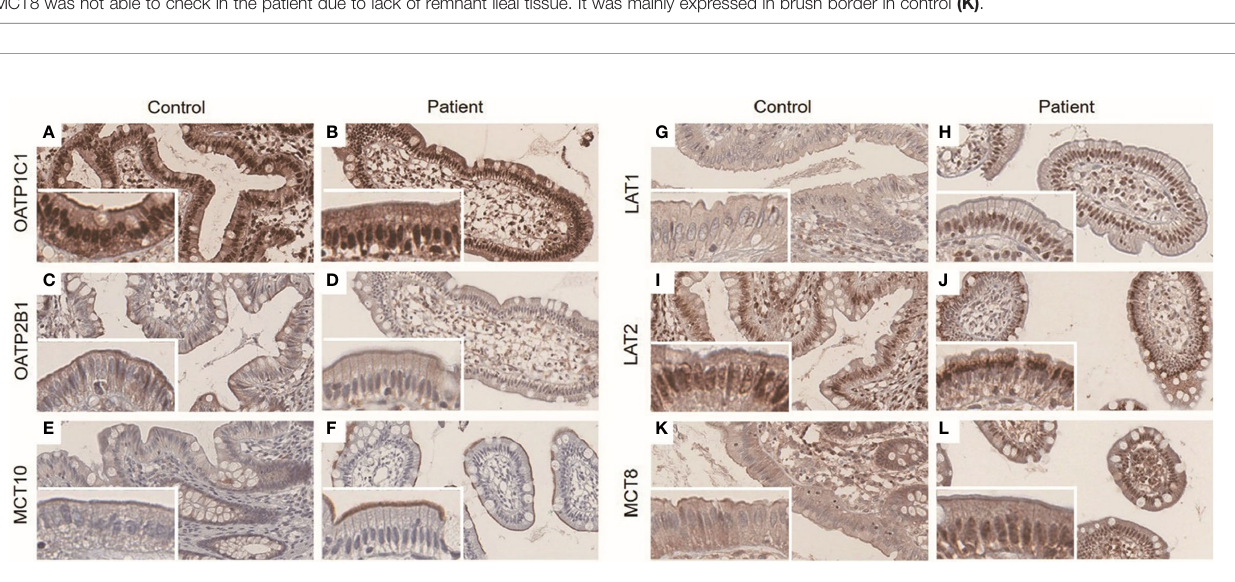
FIGURE 4 | (A – L) Immunohistochemistry result of ileal LT4 transporters in ascending colon. The panels were taken at × 20 magni fi cation, and inset represents × 40 magni fi cation. OATP1C1 was expressed in both nucleus and brush border in control (A) and the patient (B) . OATP2B1 was expressed in brush border in control (C) and the patient (D) . MCT10 staining was weak and limited to brush border in control (E) and the patient (F) . LAT1 was mainly stained at brush border in control (G) , but was mainly stained at nucleus in the patient (H) . While LAT2 was stained at both nucleus and brush border in control (I) , it was stained at only perinuclear area in the patient (J) . MCT8 was expressed in brush border in control (K) , but was expressed in both nucleus and brush border in the patient (L) .